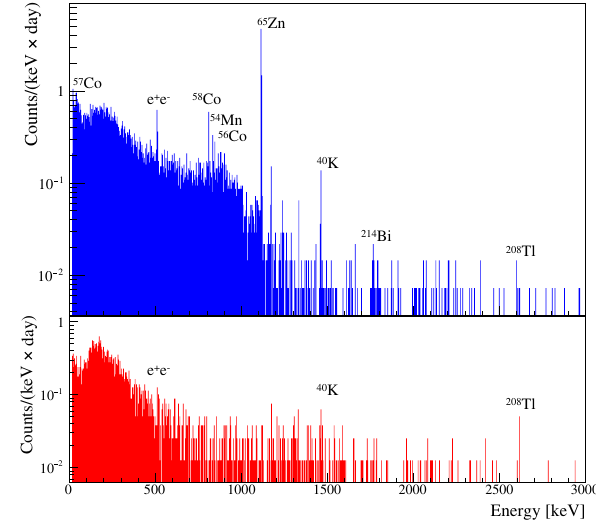
Fig. 2 Energy spectrum acquired with the GeMPI-4 ULB-HPGe spec- trometer with 10.08 kg of natural zinc over 827.66 h (top), and without the Zn sample over 474.35 h (bottom)